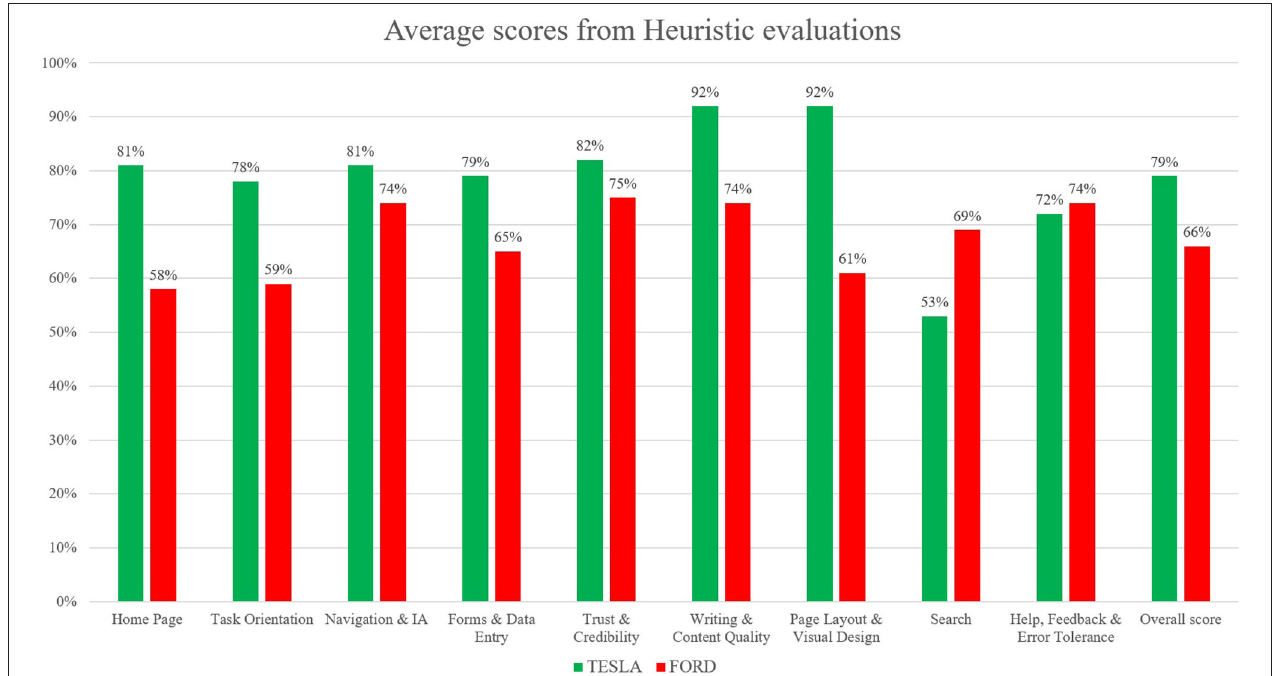
FIGURE 5 | Results from the heuristic evaluation analysis performed by five judges as professional experts in the field of User Experience (UX). The heuristic evaluation was performed in order to provide a qualitative evaluation about a traditional technique applied to assess UX; no statistical analysis was applied to the collected data. The overall scores show that the Tesla website provides a better UX in comparison with the Ford website (Tesla scored 79%, while Ford 66%). In particular, the dimensions of: “Home Page,” “Writing and Content Quality,” “Page Layout and Visual Design,” and “Task orientation” show the highest gap between the two